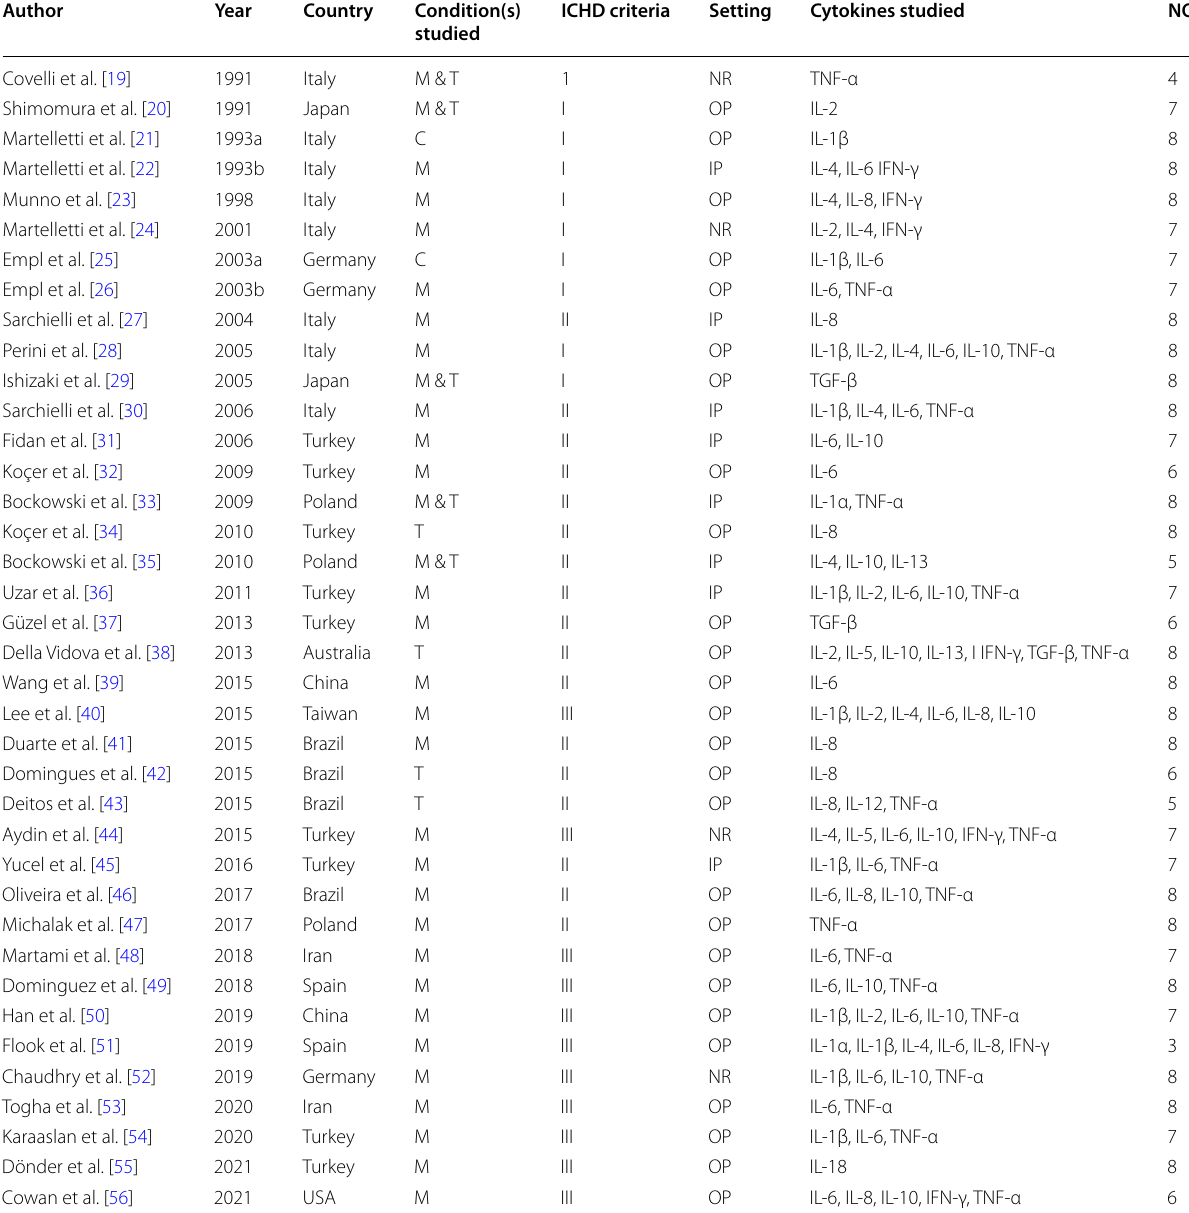
Table 1 Summary of individual studies and quality assessment